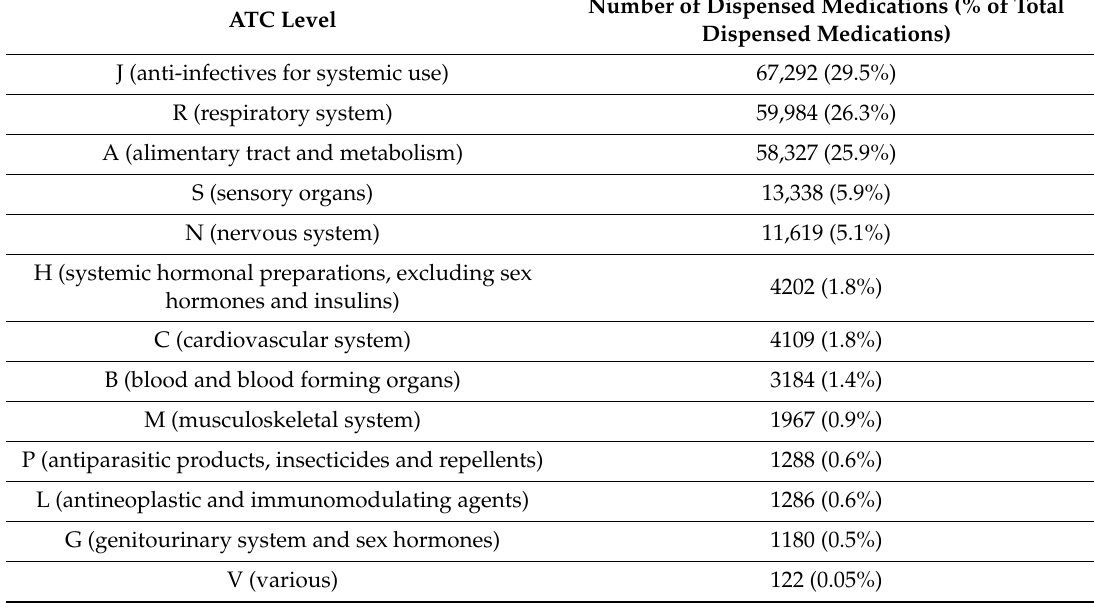
Table 1. Distribution of the dispensed medications per the Anatomical Therapeutic Chemical classification code (ATC code) 1 st level (ordered according to the frequency of dispensed medications).